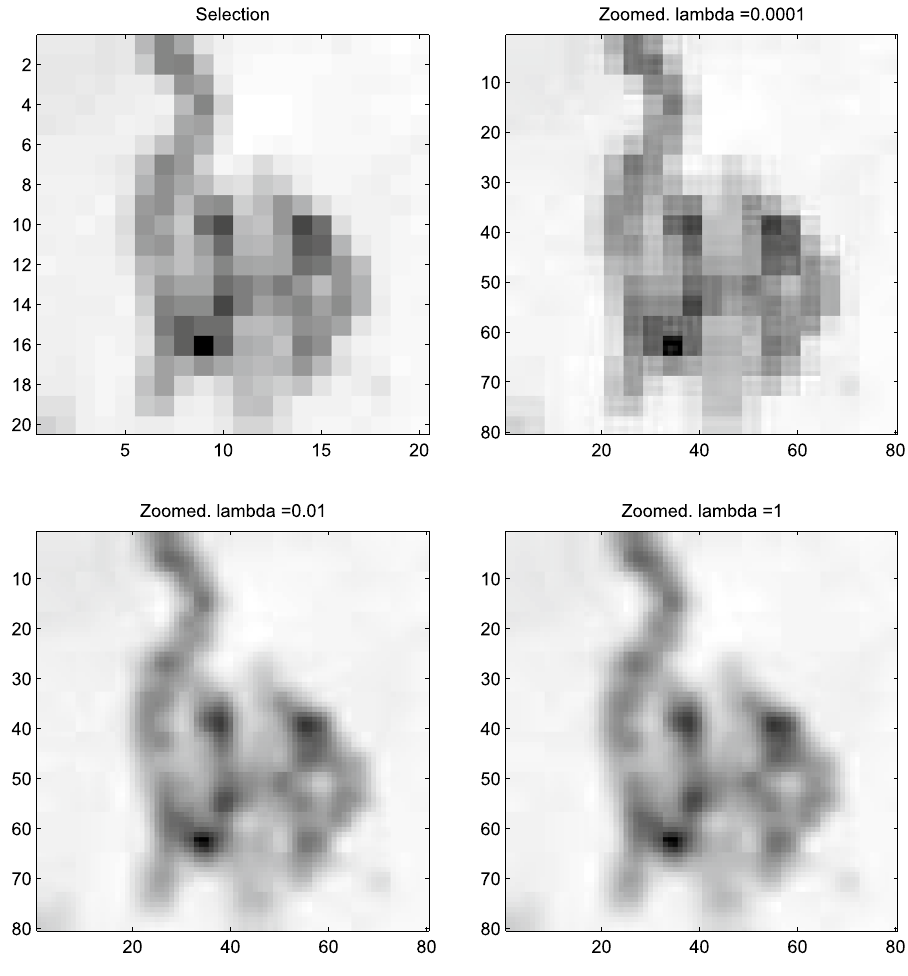
Figure 9. The influence of the roughness penalty. When (cid:31) is low, pixels of the low-resolution image appear as squares after